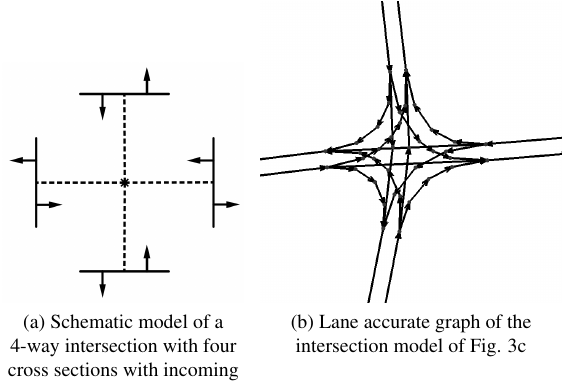
(a) Schematic model of a 4-way intersection with four cross sections with incoming and outgoing parts.